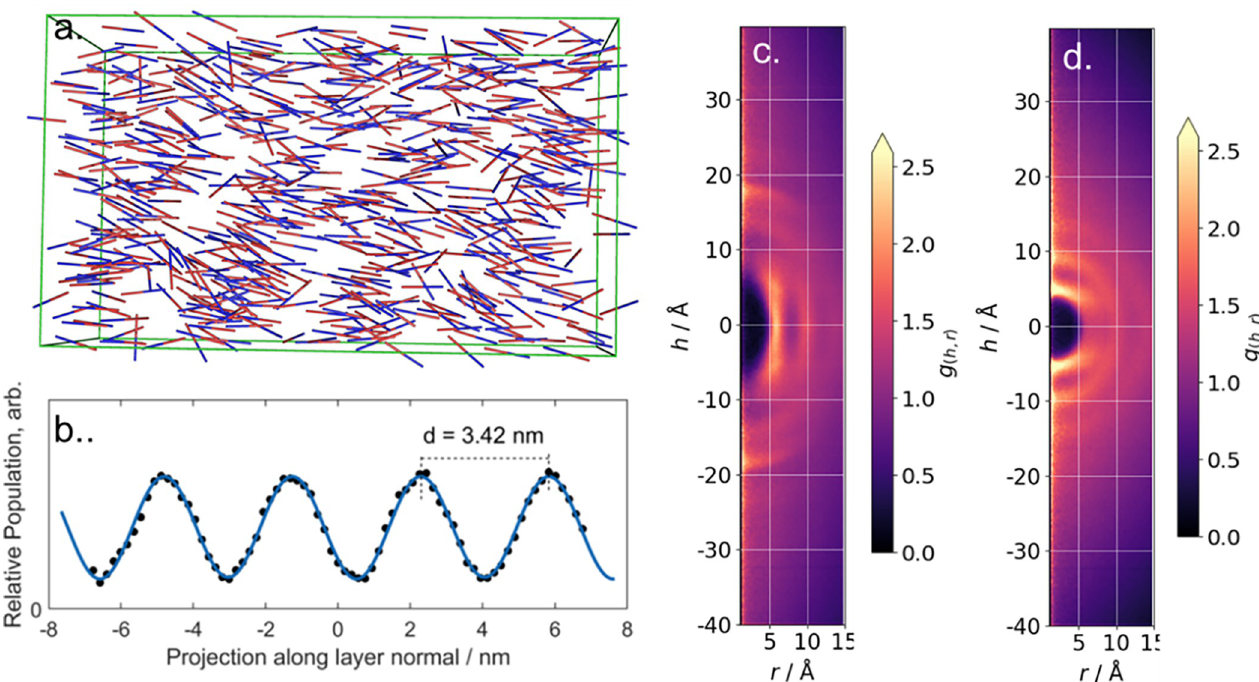
Fig 5. (a) Instantaneous configuration of the SmA mesophase formed by 8OCB (T = 365 K, t = 216 ns); here, to aid visualisation, we depict each molecule as a rod that extends from the nitrogen to the oxygen atom of 8OCB; (B) Calculated relative centre-of-mass populations along the layer normal using gmx density as described in the text; the solid line is a Fourier fit, presented as a guide to the eye. CDF plots generated with Cylindr for the SmA phase of 8OCB; the cylinder length being oriented along the layer normal (c) and in the layer plane (d), in both cases the orientation of the cylinder length was set with the–ori flag, specifying “nem” and “perp1” for orientation along and perpendicular to the layer normal, respectively.